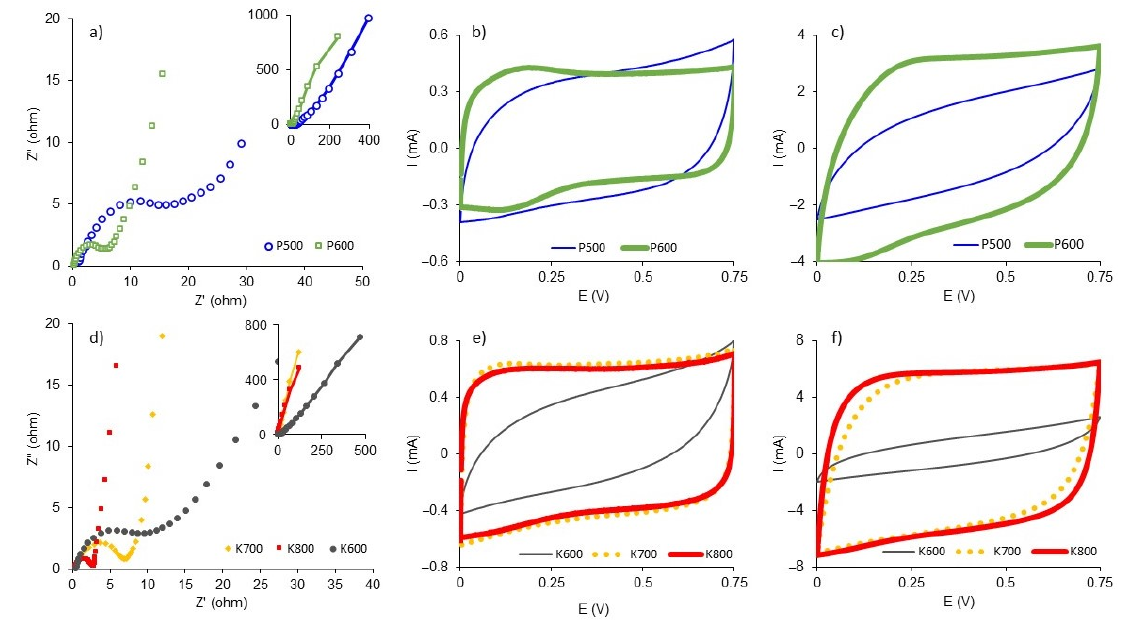
Figure 8. ( a ) Nyquist plot, cyclic voltammetry curves at ( b ) 2 mV s −1 and ( c ) 25 mV s −1 for samples BNCA-P, and ( d ) Nyquist plot and cyclic voltammetry curves at ( e ) 2 mV s −1 and ( f ) 25 mV s −1 for samples BNCA-K at 1 M H 2 SO 4 .